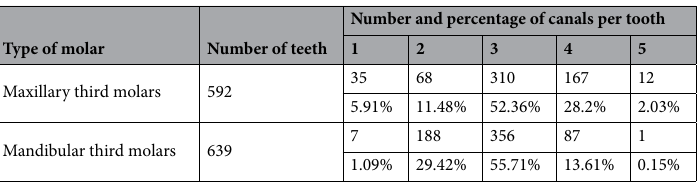
Table 2. Number and percentage of canals per